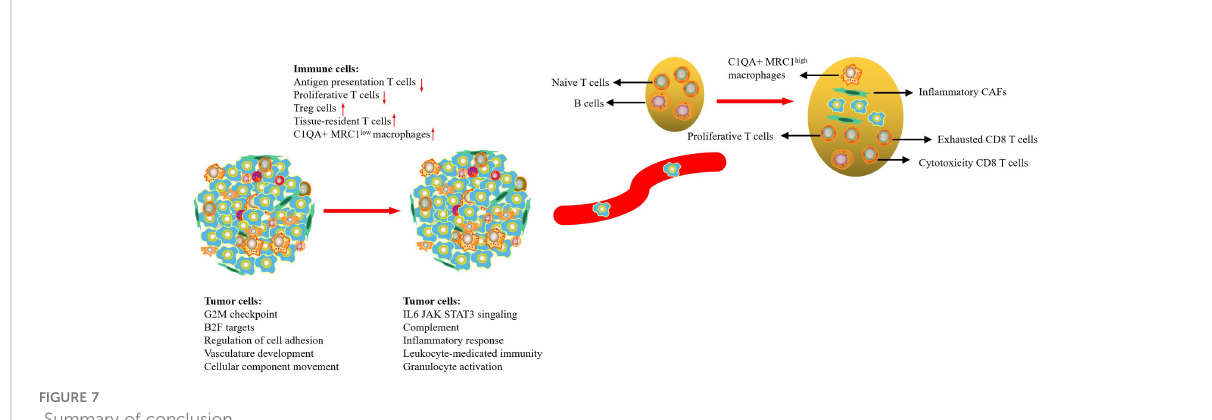
FIGURE 7 Summary of